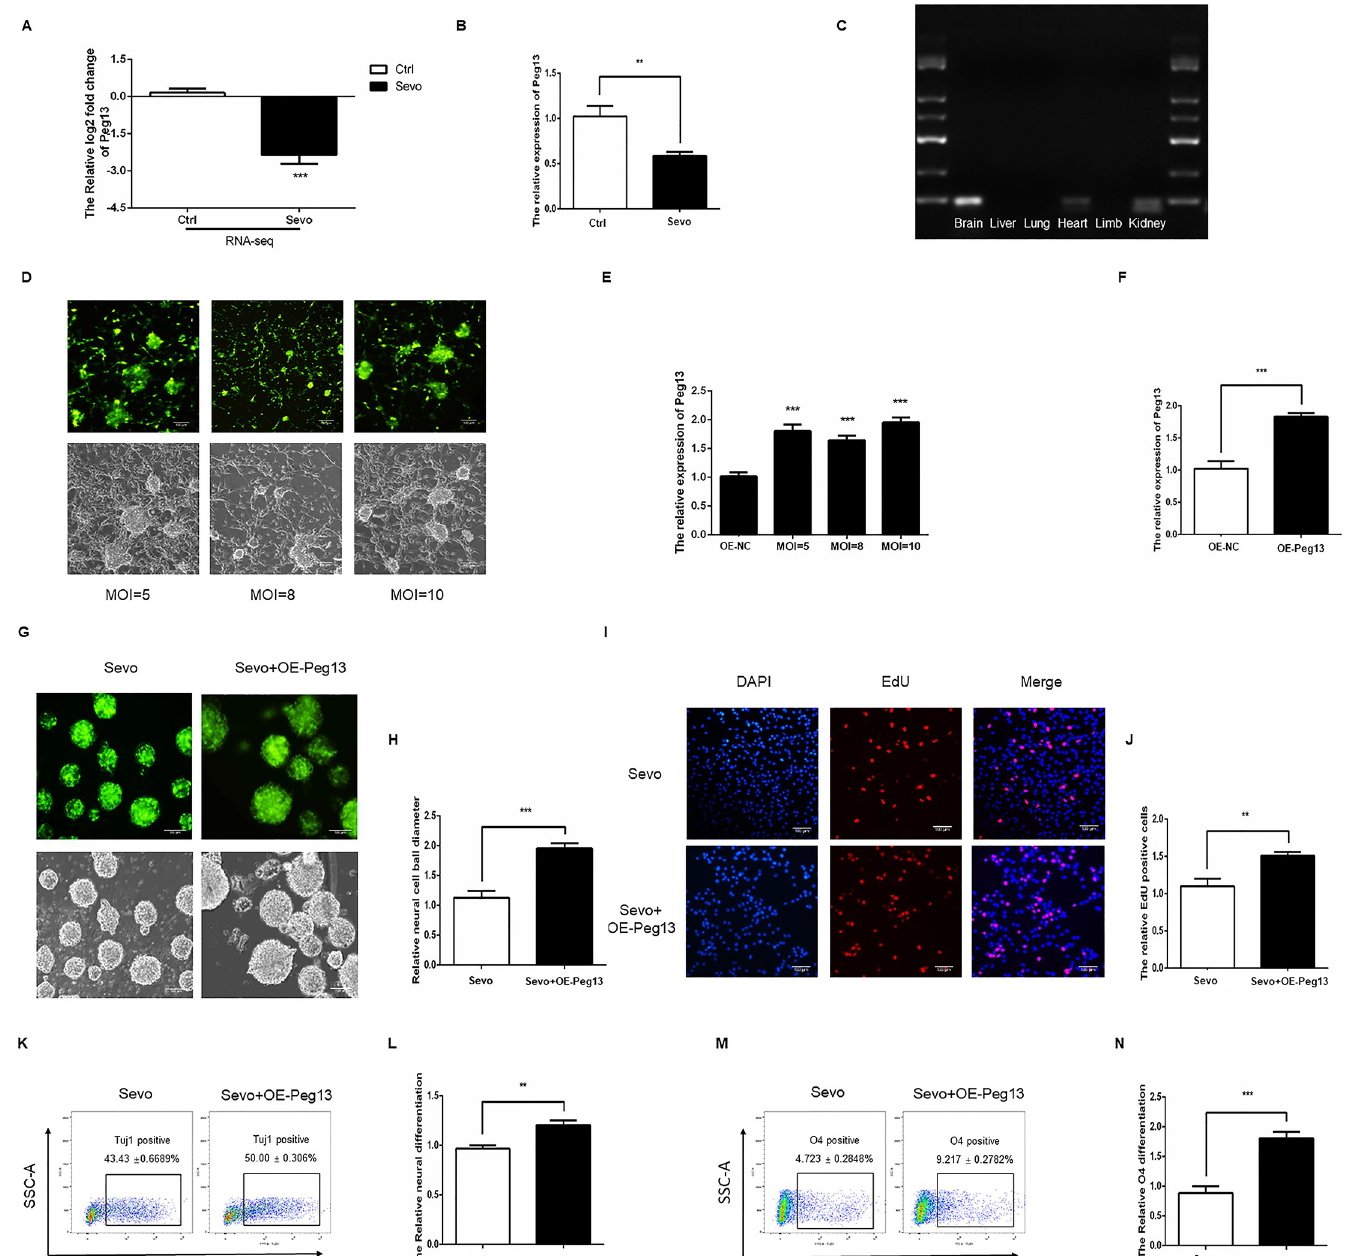
Fig 4. Peg13 attenuates the sevoflurane-induced NSC damage. A. RNAseq assay indicated that sevoflurane significantly reduced Peg13 transcripts in NSCs. B. Quantitative RT-PCR revealed that sevoflurane significantly reduced Peg13 transcripts in NSCs. C. Agarose gel electrophoresis assay displayed high levels of Peg13 transcripts in the brain of mice. D, E. Transduction with different doses of OE-Peg13 lentivirus for Peg13 expression increased Peg13 transcripts in NSCs a dose- dependent manner, determined by fluorescent microscopy and qRT-PCR. F. Transduction with OE-Peg13 at MOI of 10 increased Peg13 transcripts by 1.8 folds, determined by qRT-PCR. G, H. Peg13 over-expression recovered the sevoflurane-decreased neurosphere formation in NSCs. I, J. Peg13 over-expression restored the sevoflurane-decreased EdU incorporation in NSCs. K-N. Flow cytometry analyses revealed that Peg13 over-expression promoted the neuronal and oligodendrocyte differentiation in the sevoflurane-exposed NSCs. Data are representative images, charts or expressed as the mean ± SEM of each group of cells from three separate experiments. � P < 0.05, �� P < 0.01, ��� P < 0.001, determined by Student T test.